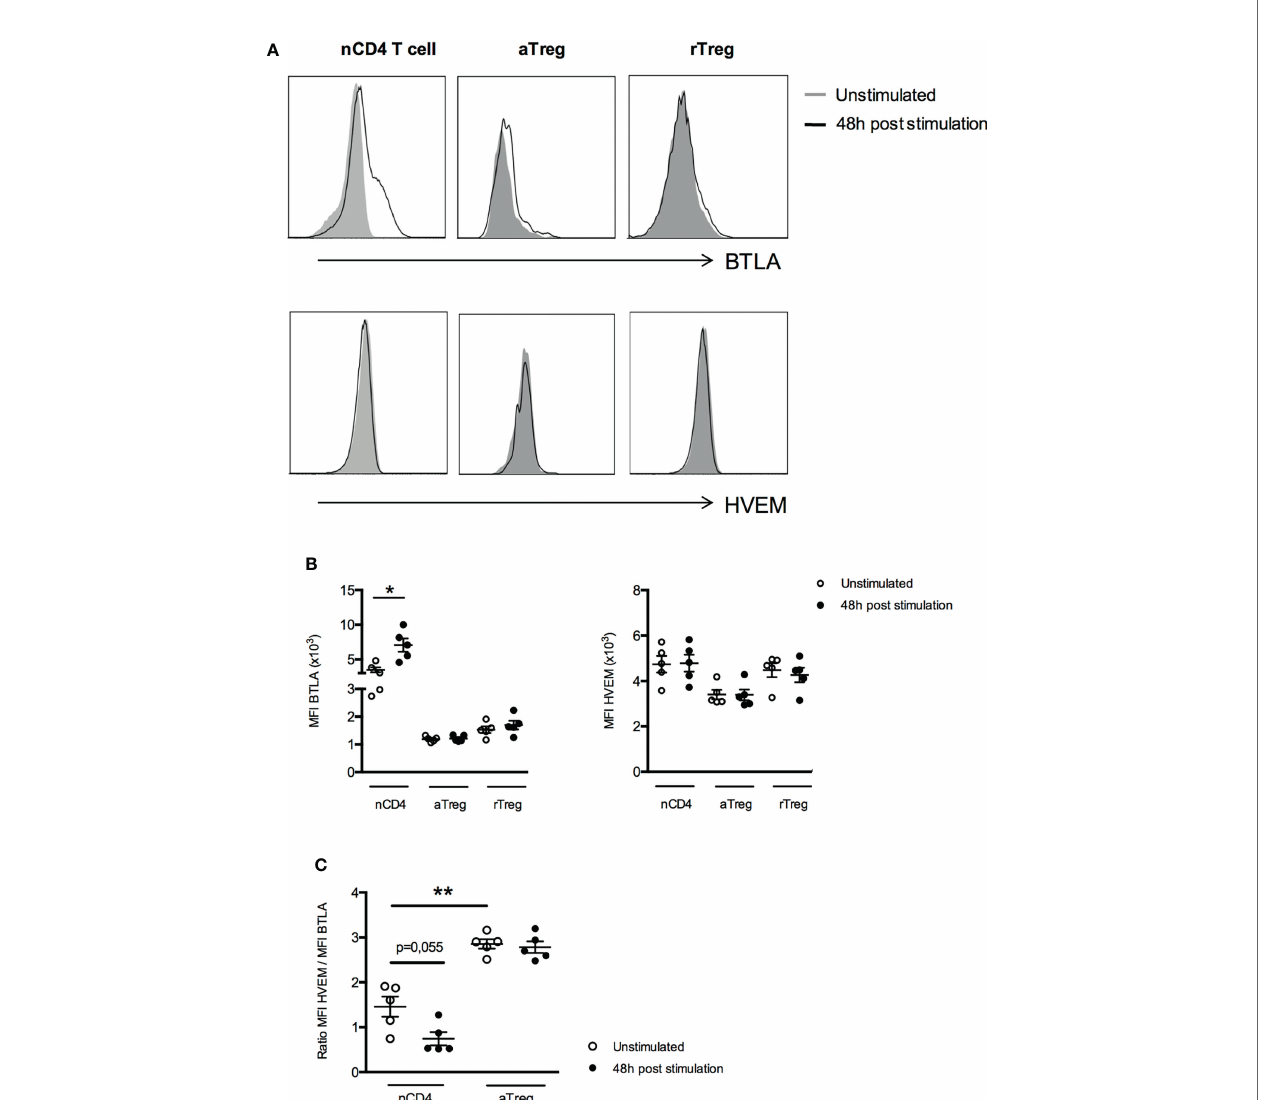
FIGURE 5 | Expression of BTLA and HVEM proteins by Treg subsets do not change after activation. (A) Representative histograms of BTLA and HVEM expression on unstimulated naive CD4 + T cells (nCD4), aTregs and rTregs or following 48h of stimulation. Data from a representative experiment are shown as an example. (B) BTLA and HVEM expression (MFI) after 48 hours of stimulation (anti-CD3 5µg/ml and anti-CD28 5µg/ml, n=5). (C) Comparison of the ratio of HVEM and BTLA expression in naive CD4 + T cells and aTregs in the absence of stimulation (white dots, n=5) and following 48h of TCR stimulation (black dots, n=5). Results are expressed as mean ± SEM and each dot represents one individual. *p < 0.05; **p < 0.01, Mann-Whitney